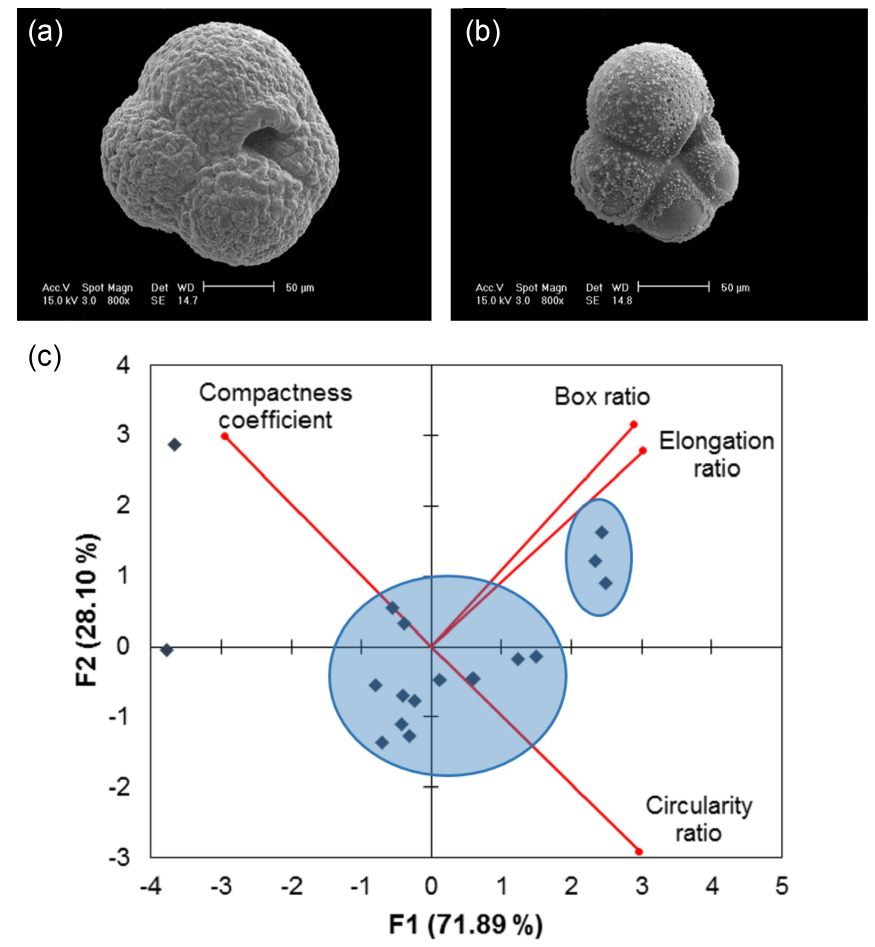
Figure 5. Scanning electron microscope images of (a) post-reproduction adult Neogloboquadrina pachyderma (with secondary crust) and (b) pre-adult morphotype (showing evidence of dissolution). (c) Example PCA biplot of 16 September 2007 normalised size-invariant morphological variables showing clustering of data points (blue circles). F1 is the first principal component axis; F2 is the second principal component axis. Proportion of variance explained by each axis shown in parentheses (further details are found in the Supplement Sect.